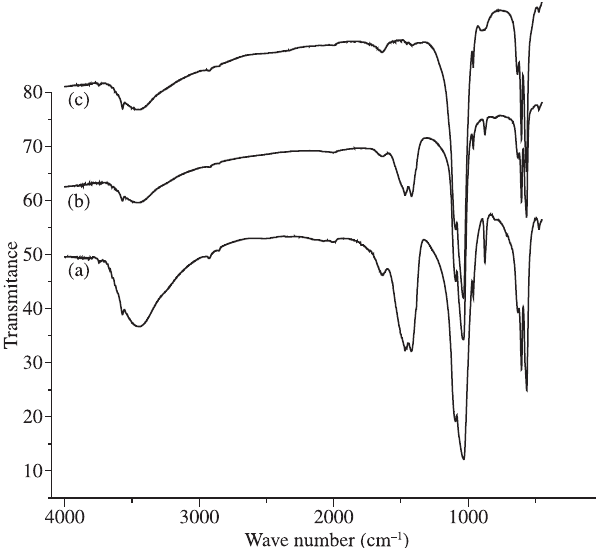
Figure 3. FTIR spectra for HAP particles synthesized in liquid crystal phases formed from a) Renex-60 TM , b) Renex-100 TM and c) for commercial hydroxyapatite.